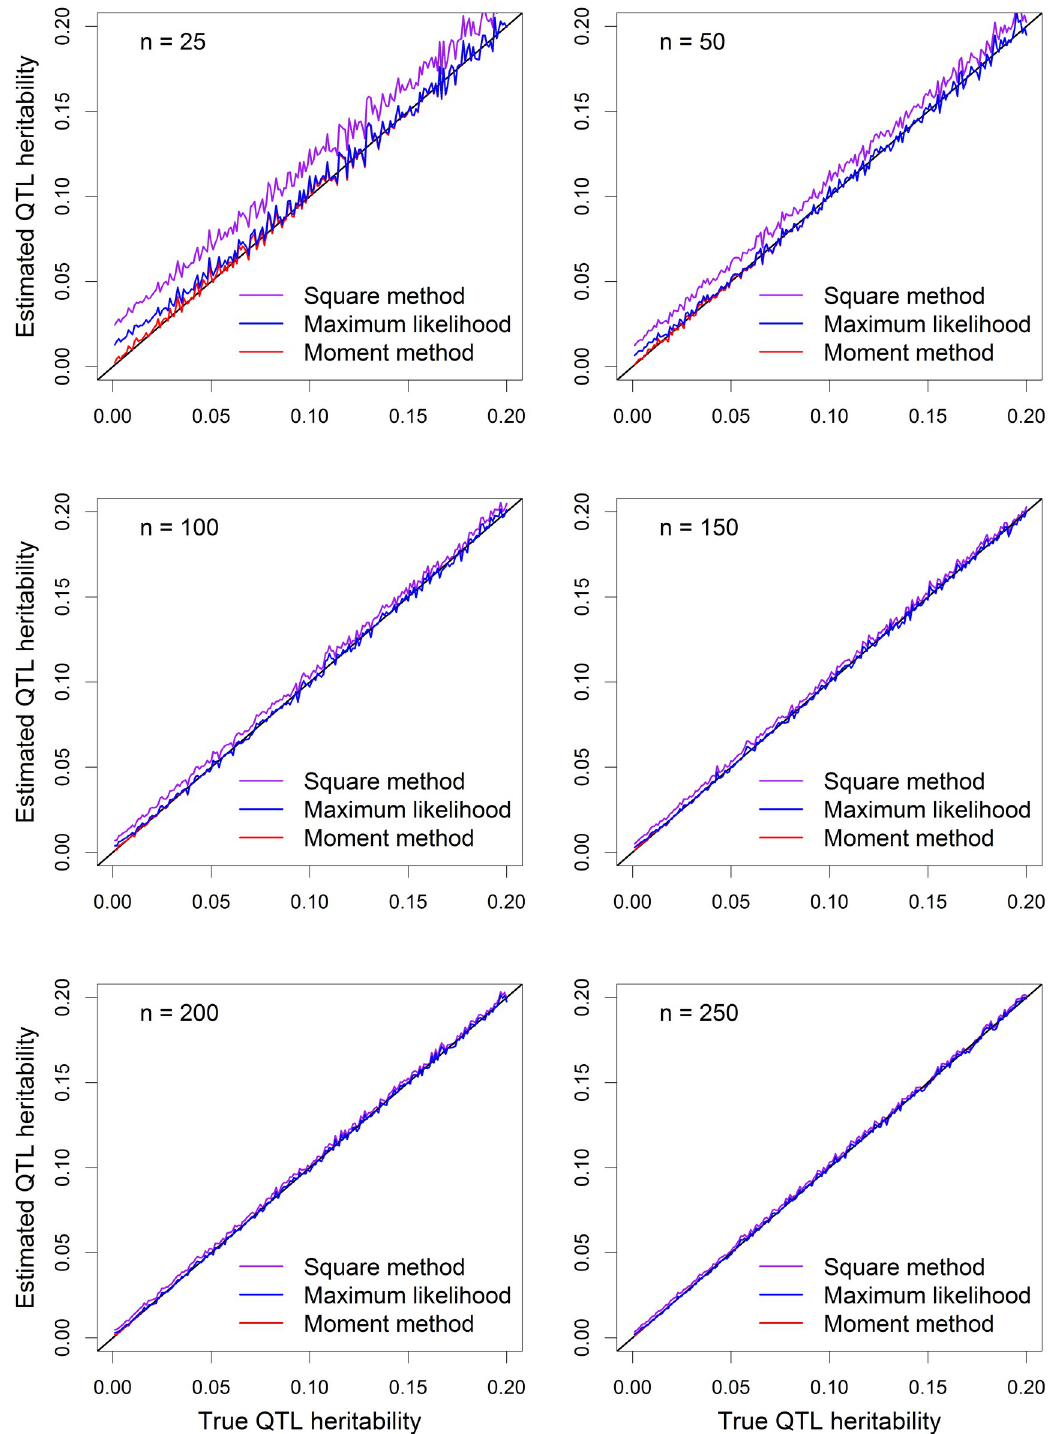
Fig 5. Plots of estimated QTL heritability against the true QTL heritability under the polygenic model. The six panels of the figure show the results of six sample sizes ( n ), which are 25, 50, 100, 150, 200 and 250, respectively.